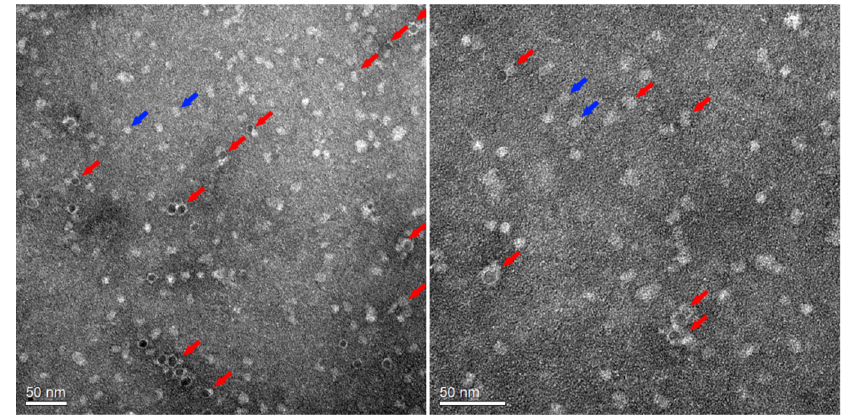
Figure 4. TEM images of CdS–ME NPs: αL158C MoFe-P biohybrid systems (red arrows). The blue arrows indicate non-absorbed αL158C MoFe-P. Glow discharging was performed for carbon-coated grids, and samples were stained with uranyl acetate (1%).